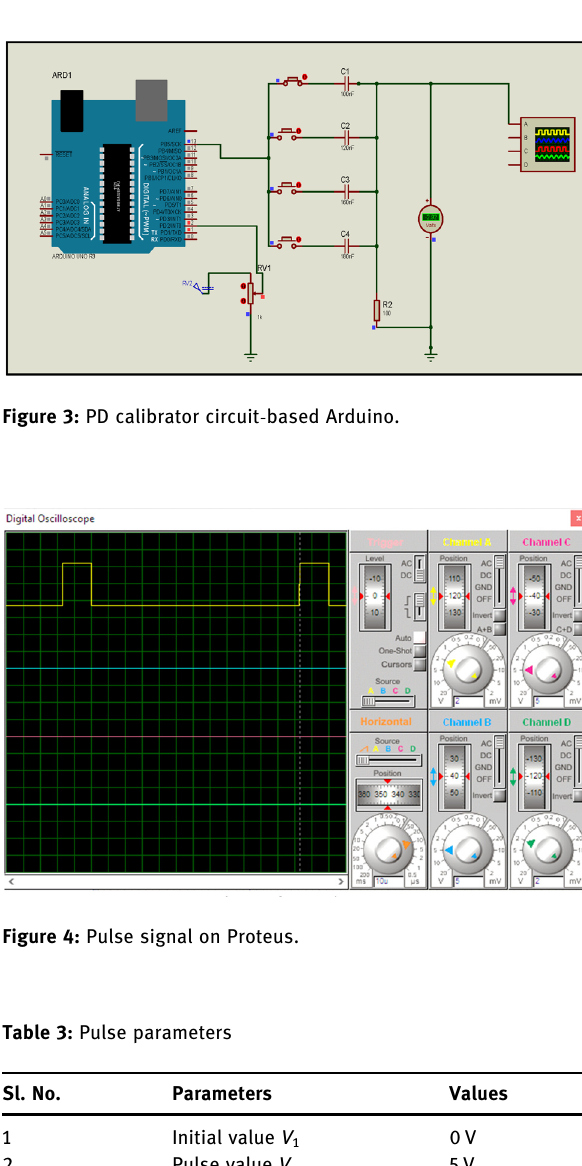
Figure 2: PD pulse generator.